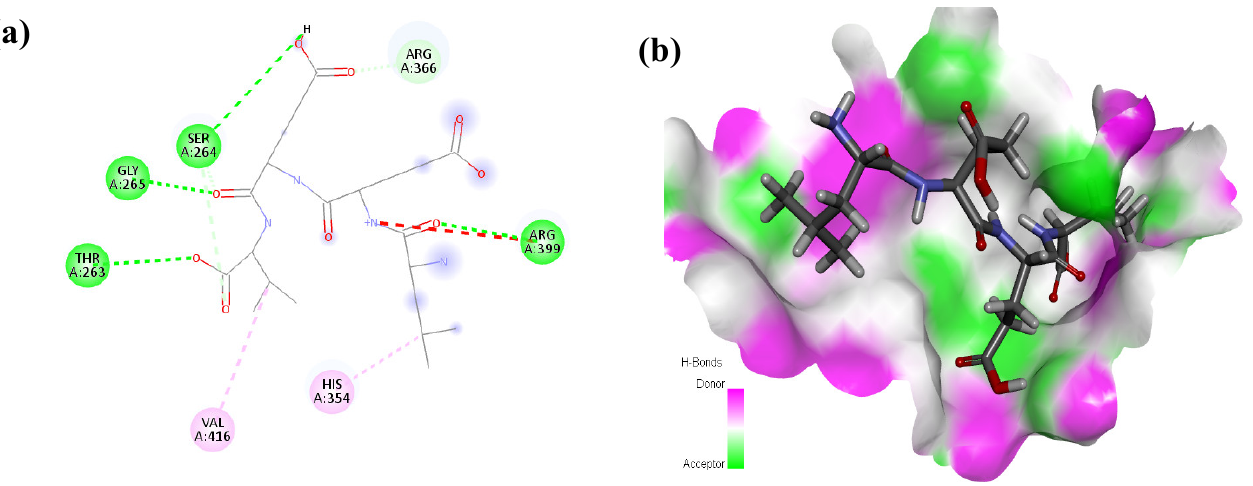
Figure 3. Interaction ( a ) and binding pattern ( b ) of LEEV peptide with ORF2 (capsid protein) with HEV as receptor.